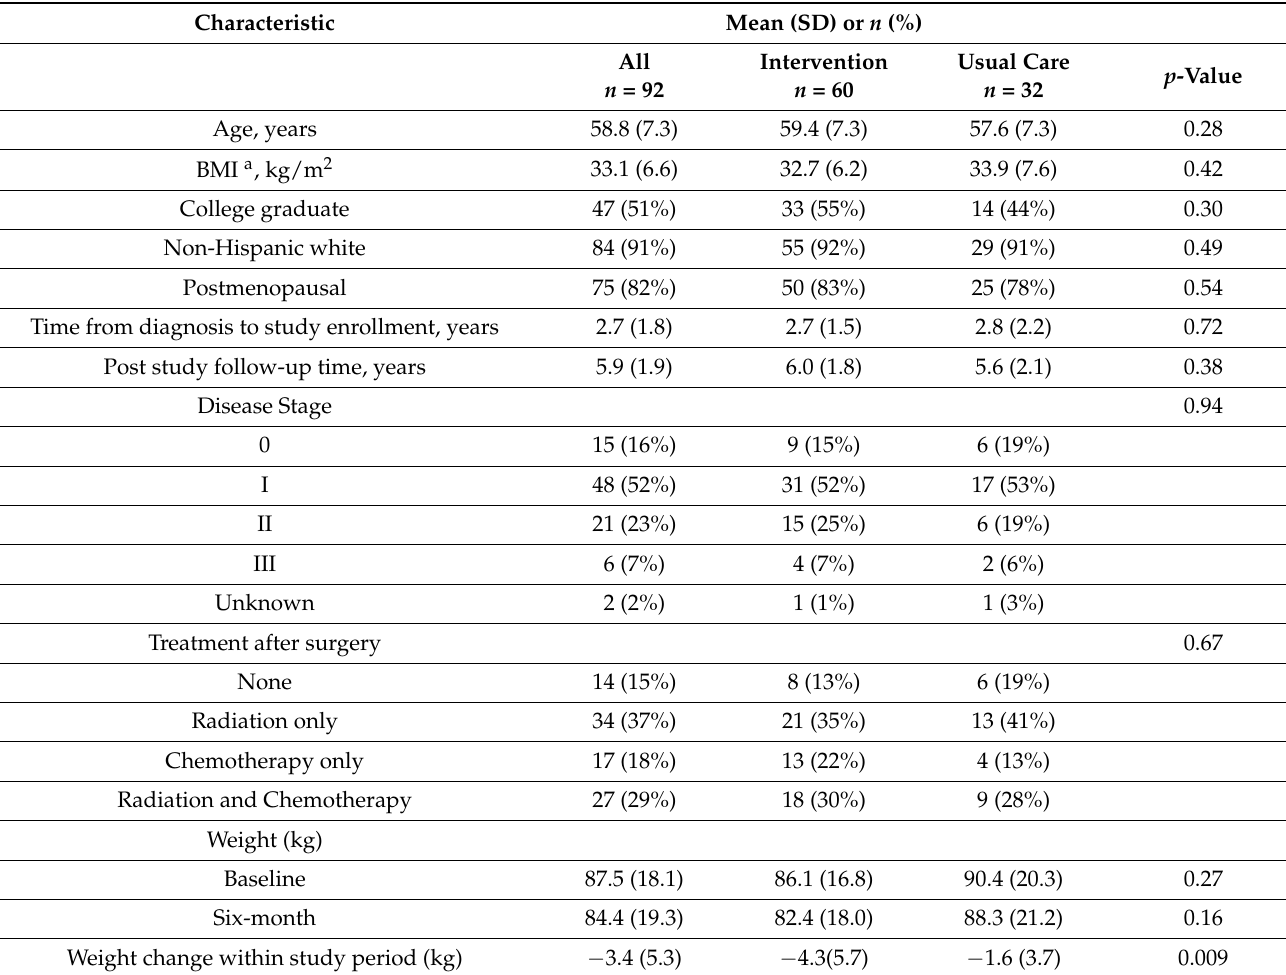
Table 1. Baseline characteristics of Lifestyle, Exercise and Nutrition (LEAN) Study participants with long-term weight data ( n =